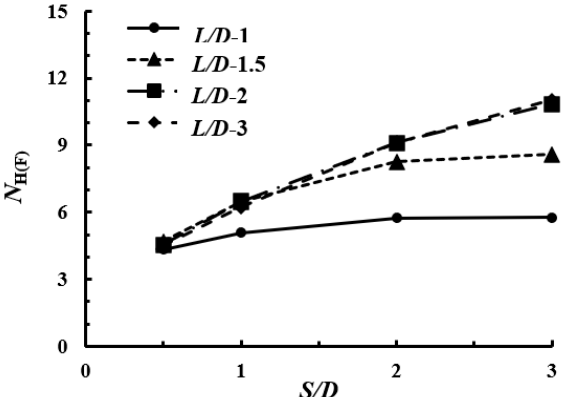
Figure 8. Horizontal dimensionless load with L / D and S / D ratios.